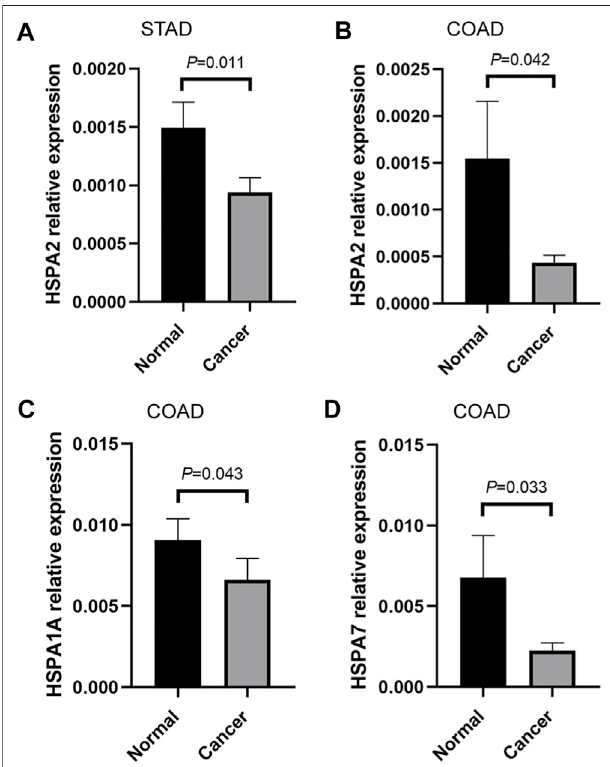
FIGURE 8 | qRT-PCR validation of HSPs in vivo . (A) The mRNA relative expression of HSPA2 detected by qRT-PCR in STAD. (B) The mRNA relative expression of HSPA2 detected by qRT-PCR in COAD. (C) The mRNA relative expression of HSPA1A detected by qRT-PCR in COAD. (D) The mRNA relative expression of HSPA7 detected by qRT-PCR in COAD (Measurement data were expressed as mean ± SEM, p < 0.05). COAD, colon adenocarcinoma. HSPs, heat shock proteins. qRT-PCR, quantitative real- time polymerase chain reaction. STAD, stomach adenocarcinoma. SEM, standard error